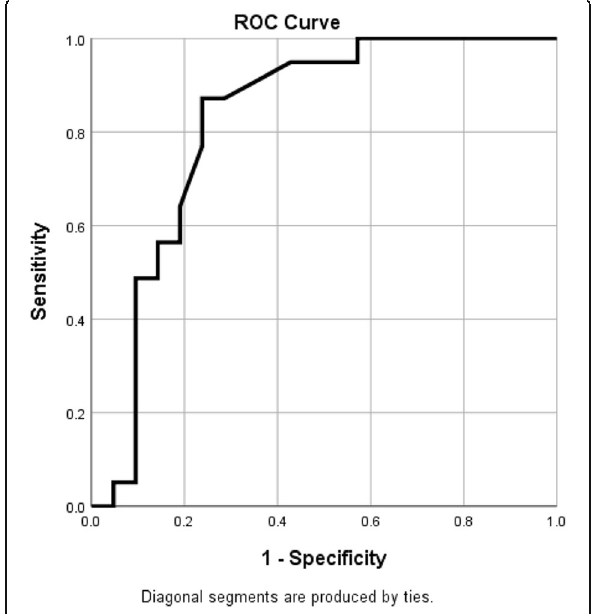
Fig. 5 ROC curve analysis for SR